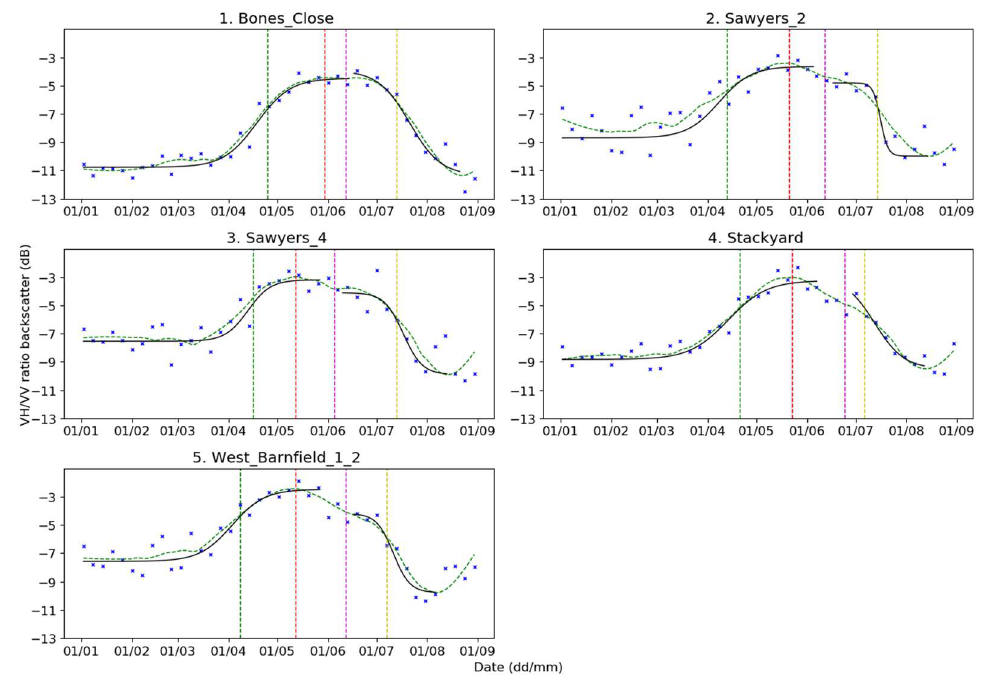
Figure 7. VH/VV ratio time series (blue dots) with the smoothed curve (green dashed line) and two logistic curves fitted (black line) for five fields (subplots 1–5) during 2018, orbit 132. The vertical dotted lines indicate the dates of G_midP (green), TZmax (red), inflorescence (purple), and S_midP (yellow), as determined from the VH/VV backscatter time series analysis.